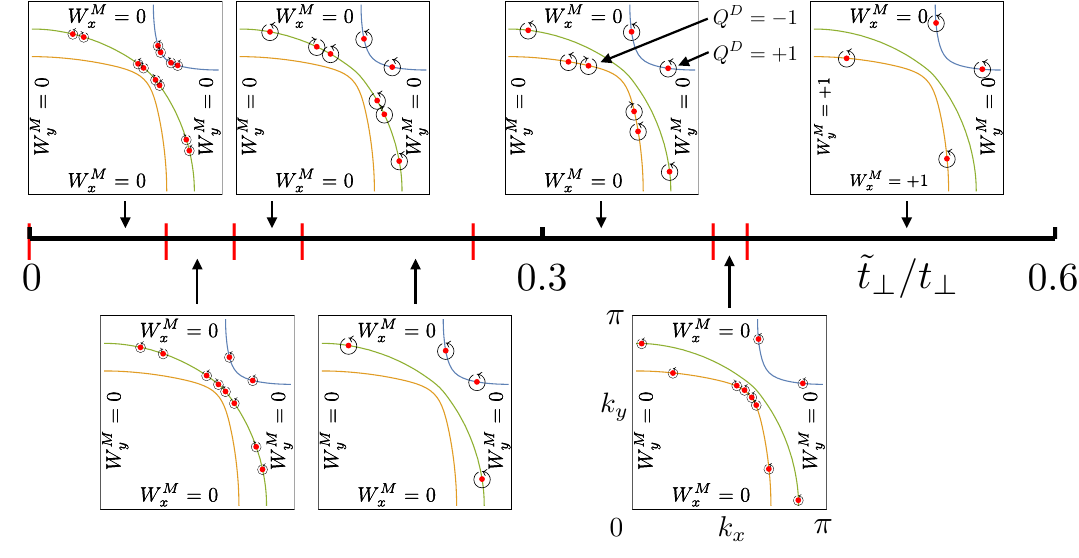
Figure 9: Phase diagram for the three layer system as a function of the tunneling strength ˜ t ⊥ to the upper Sr IrO for the phase difference between the superconductors ϕ = π . As ˜ t ⊥ 2 4 is increased the system goes through several phase transitions as Dirac nodes are nucleated and annihilated close to the Fermi lines of the α , β and γ bands. In the last transition shown with increasing ˜ t ⊥ the system becomes a topological mirror superconductor with W M ,0 = 1 as pairs of Dirac nodes on the Fermi line of the γ band annihilate at the k and W M ,0 y = 0 lines. The tight-binding parameters are described in the text. For the tunneling and k y amplitudes we have used the values ˜ A = A = 0.68 and ˜ B = B =